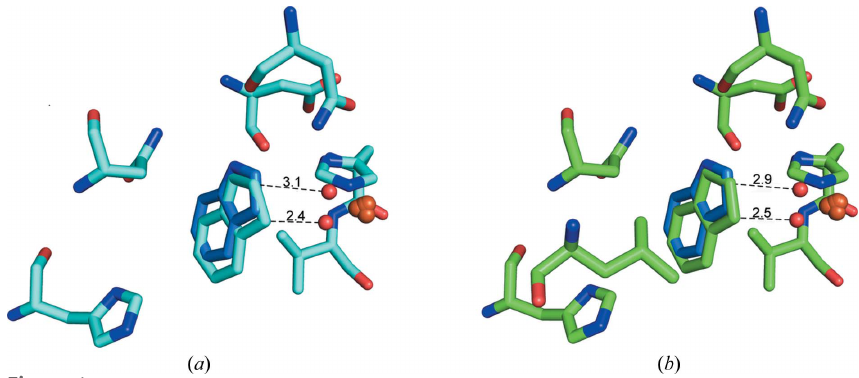
Figure 1 Wild-type NDO in complex with indan (magenta) ( a ) and with indene (green) ( b ) overlapped with that with indole (dark blue). Active-site residues of NDO are represented by sticks with green and cyan C atoms. The position of indole, from PDB entry 1o7n, is represented by blue C atoms. The mononuclear iron (overlapping orange spheres show the Fe position in the different structures reported here to illustrate the small movements in the Fe position) and modeled dioxygen (from PDB entry 1o7n; small red spheres) are also shown.